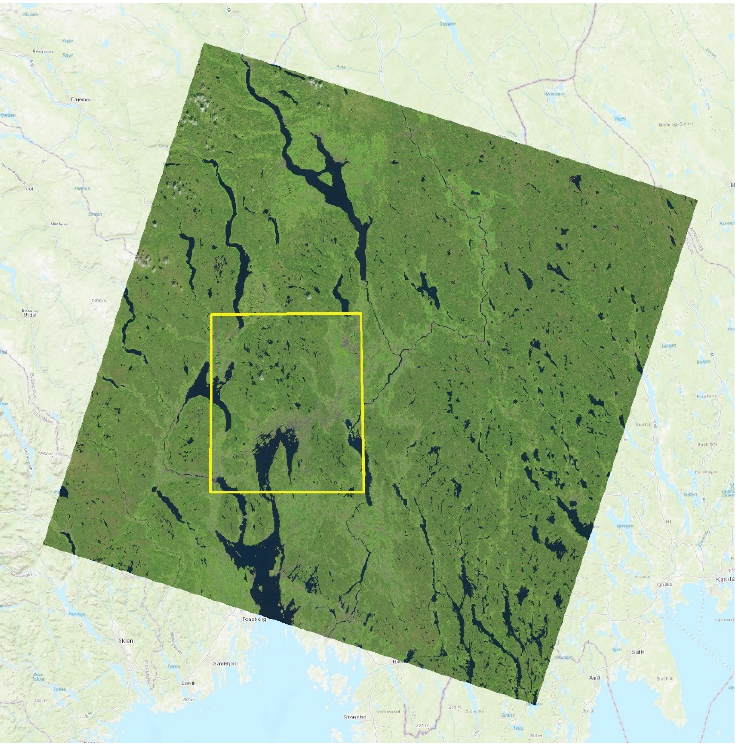
Figure 2. Landsat 8 image, pass of 3 July 2018, with ROI (yellow) superimposed on a political map of southern Norway and Sweden.